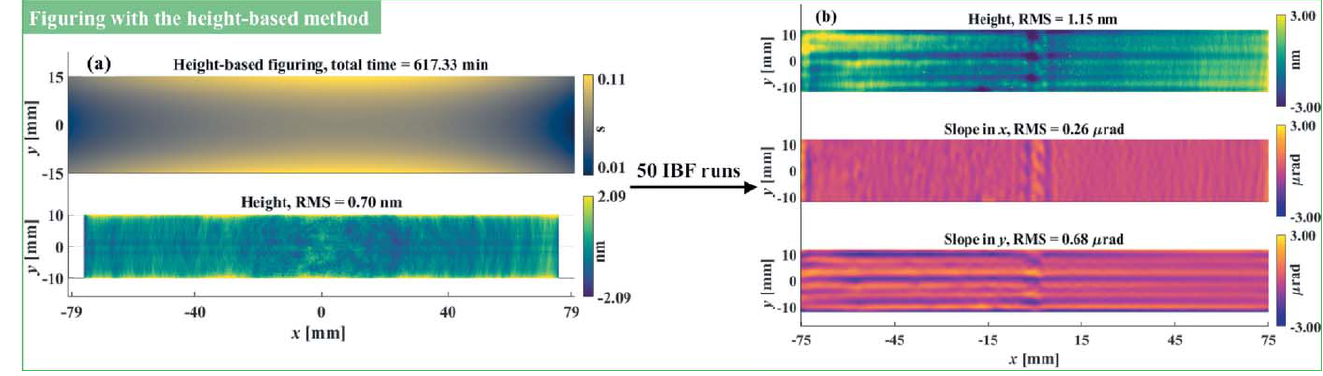
Figure 13 The initial figuring was guided by the estimation obtained from the height-based method ( a ). The figuring result after 50 IBF runs was measured with the SI system ( b ).